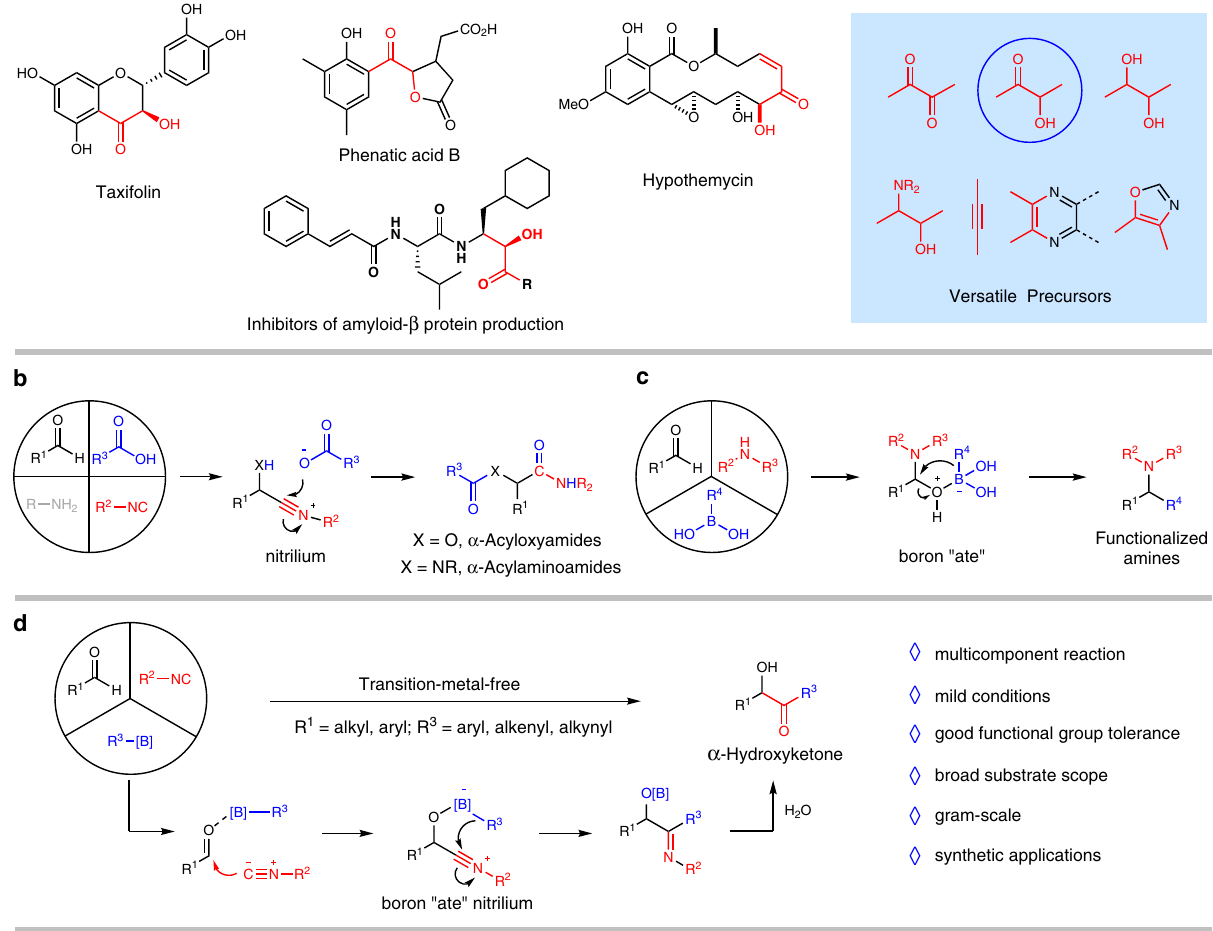
Fig. 1 Precedent works and proposed Passerini-type coupling reaction with boronic acids as nucleophilic agents. a α -Hydroxyketones in bioactive moleculars or as synthetic precursors. b Classic Passerini or Ugi reaction. c Petasis boronic acid-Mannich reaction. d Passerini-type coupling reaction of boronic acids (this